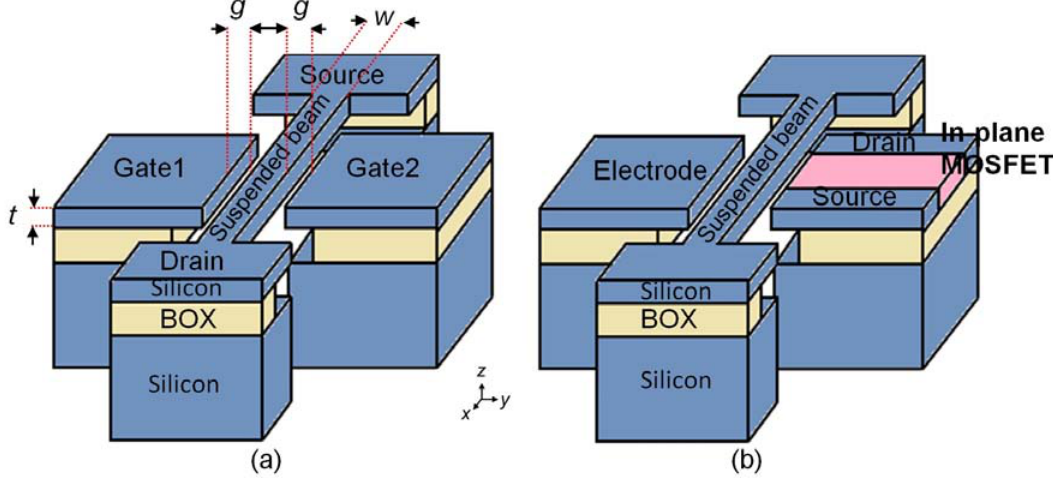
Figure 1. ( a ) The IP R-NEM sensor: A suspended beam that acts as the channel for the junction-less field-effect-transistor (JL FET) with two side gates. ( b ) The in-plane resonant suspended gate field-effect-transistor (IP RSG-FET) sensor: A suspended beam that is integrated with an in-plane metal-oxide-semiconductor FET